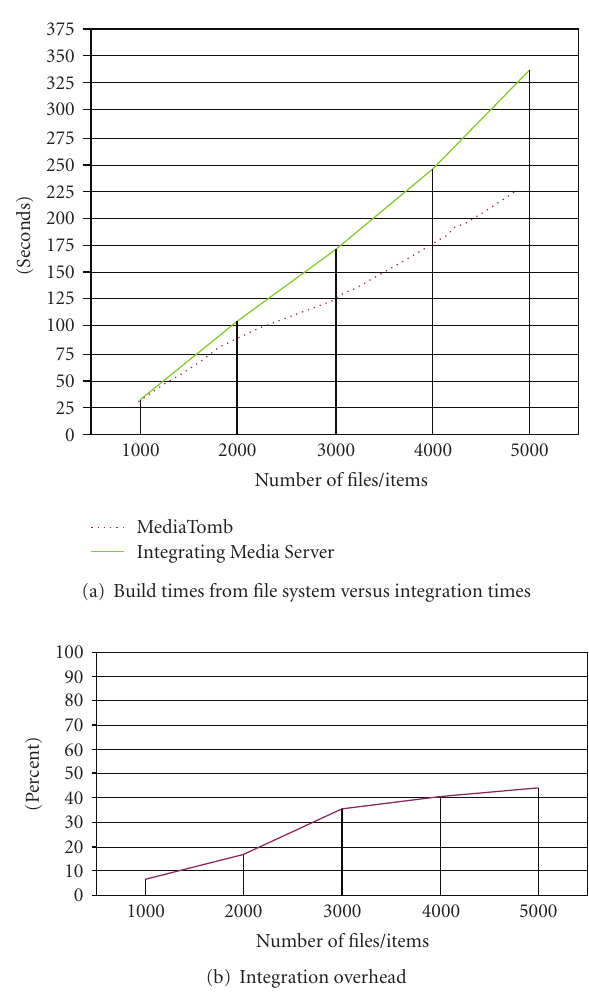
Figure 6: Overhead of integrating media